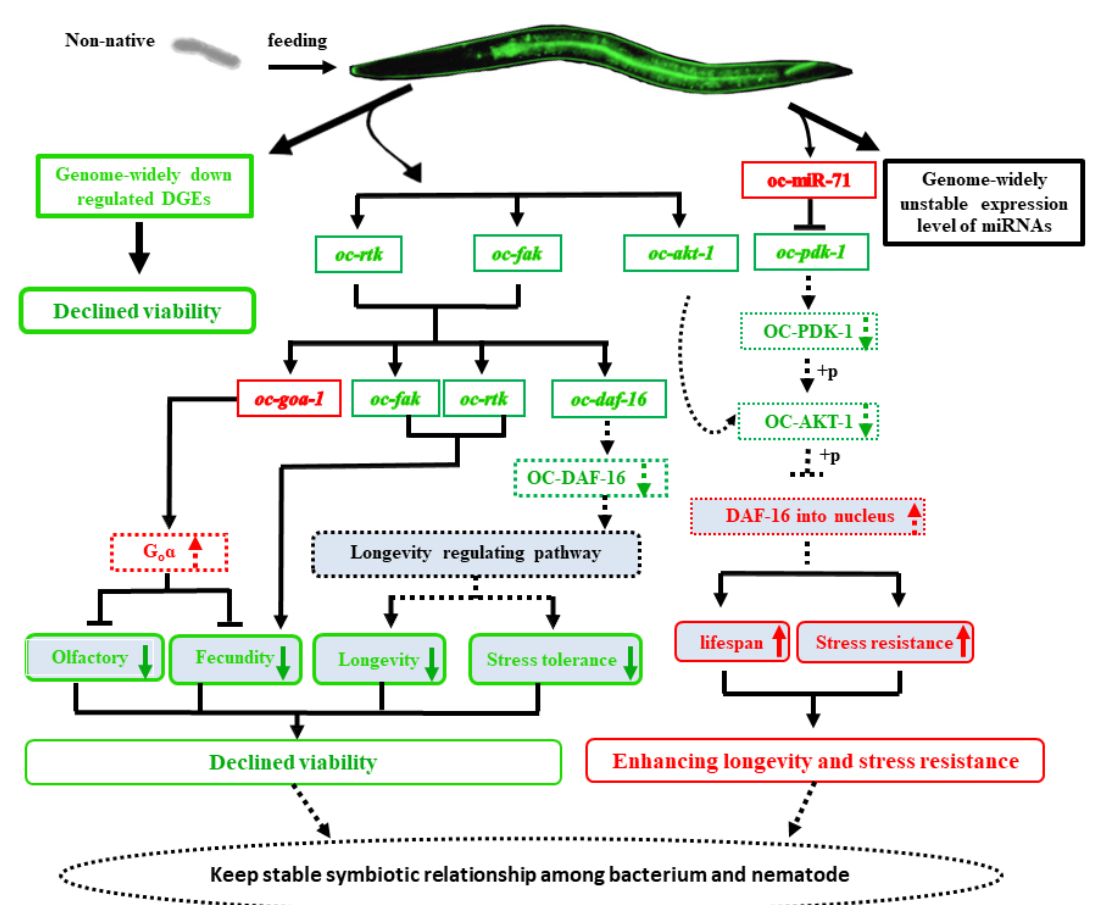
Figure 8. Predicted interaction network between Oscheius chongmingensis and its intestinal bacterial partner at global transcriptional and post-transcriptional levels. The single intestinal bacterial species S. nematodiphila orchestrates its nematode host’s viability and the stability of their symbiotic relationship at the global transcriptional and post-transcriptional levels, in part by regulating oc - rtk , oc-fak , oc - akt-1 , and oc-miR-71. Oc-fak and oc-rtk play key roles in the viability of regulatory mechanisms of O. chongmingensis by positively mediating the expression levels of each other and oc-daf-16 to indirectly impact stress tolerance and longevity, and by negatively mediating that of oc-goa-1 to indirectly influence fecundity and olfaction of the nematode. A response mechanism model at transcriptional and post-transcriptional levels for enhanced survival of O. chongmingensis when faced with the non-native intestinal bacterial strain 186 was also deduced. For a response at the transcriptional level, expression of oc-akt-1 is repressed in the non-native combination, which results in longer longevity and stronger stress tolerance to high temperature and oxidative stress through the insulin-like signaling (ILS) pathway. In the post-transcriptional level response, an upregulated miRNA, oc - miR-71, downregulates the target gene oc-pdk-1 in the ILS pathway, improving the longevity and stress tolerance of O. chongmingensis . Genes with downregulated expression in the non-native combination are indicated in green boxes and marked with green color, while genes with upregulated expression in the non-native combination are indicated in red boxes and marked with red color. Solid boxes indicate verified in this study. Dashed boxes indicate induced according to previously verified